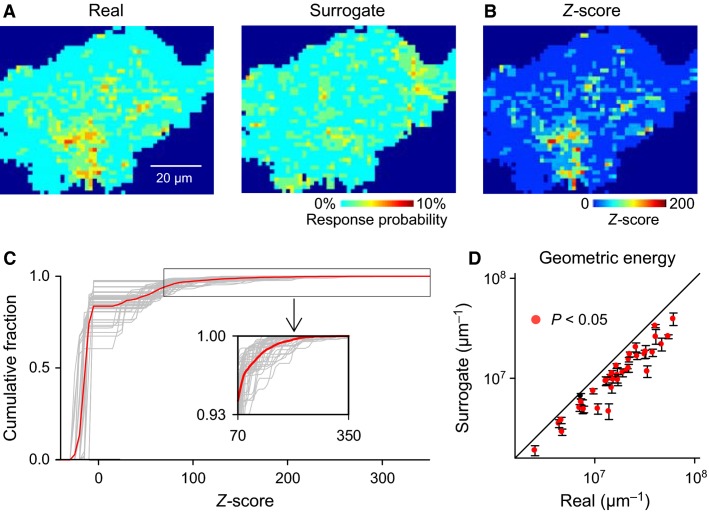
Hotspots for astrocytic calcium signals. (A), Heat maps of activated domains stacked across all 48 trials during six sessions in real data (left) and domain-shuffled surrogates (right). (B), The Z scores calculated from the response probabilities of real and surrogate datasets in A are shown for each pixel in a pseudocolored scale. (C), The cumulative distribution of the Z scores of individual pixels in each astrocyte (gray) is superimposed on their average (red), indicating that a few pixels exhibited extremely high-Z values. (D), The mean geometric energy of the spatial distribution of the Z score within individual cells is compared between 37 real datasets and their 1,000 domain-shuffled surrogates. Red dots represent astrocytes with significantly high-geometric energy, indicating that highly responsive pixels were spatially clustered.